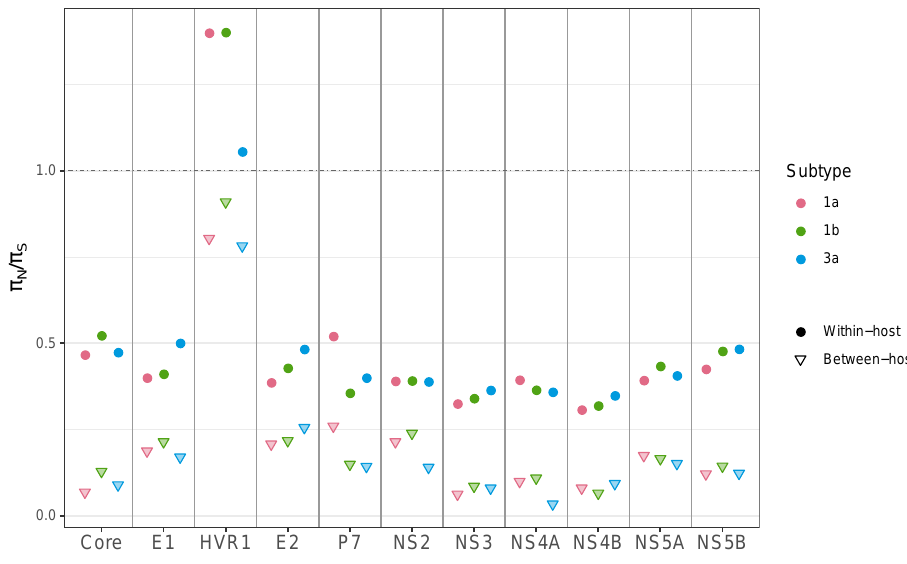
Figure 8. Between-host selective pressures ( π N / / π S) on different HCV genomic regions, in compari- son with those within hosts (in